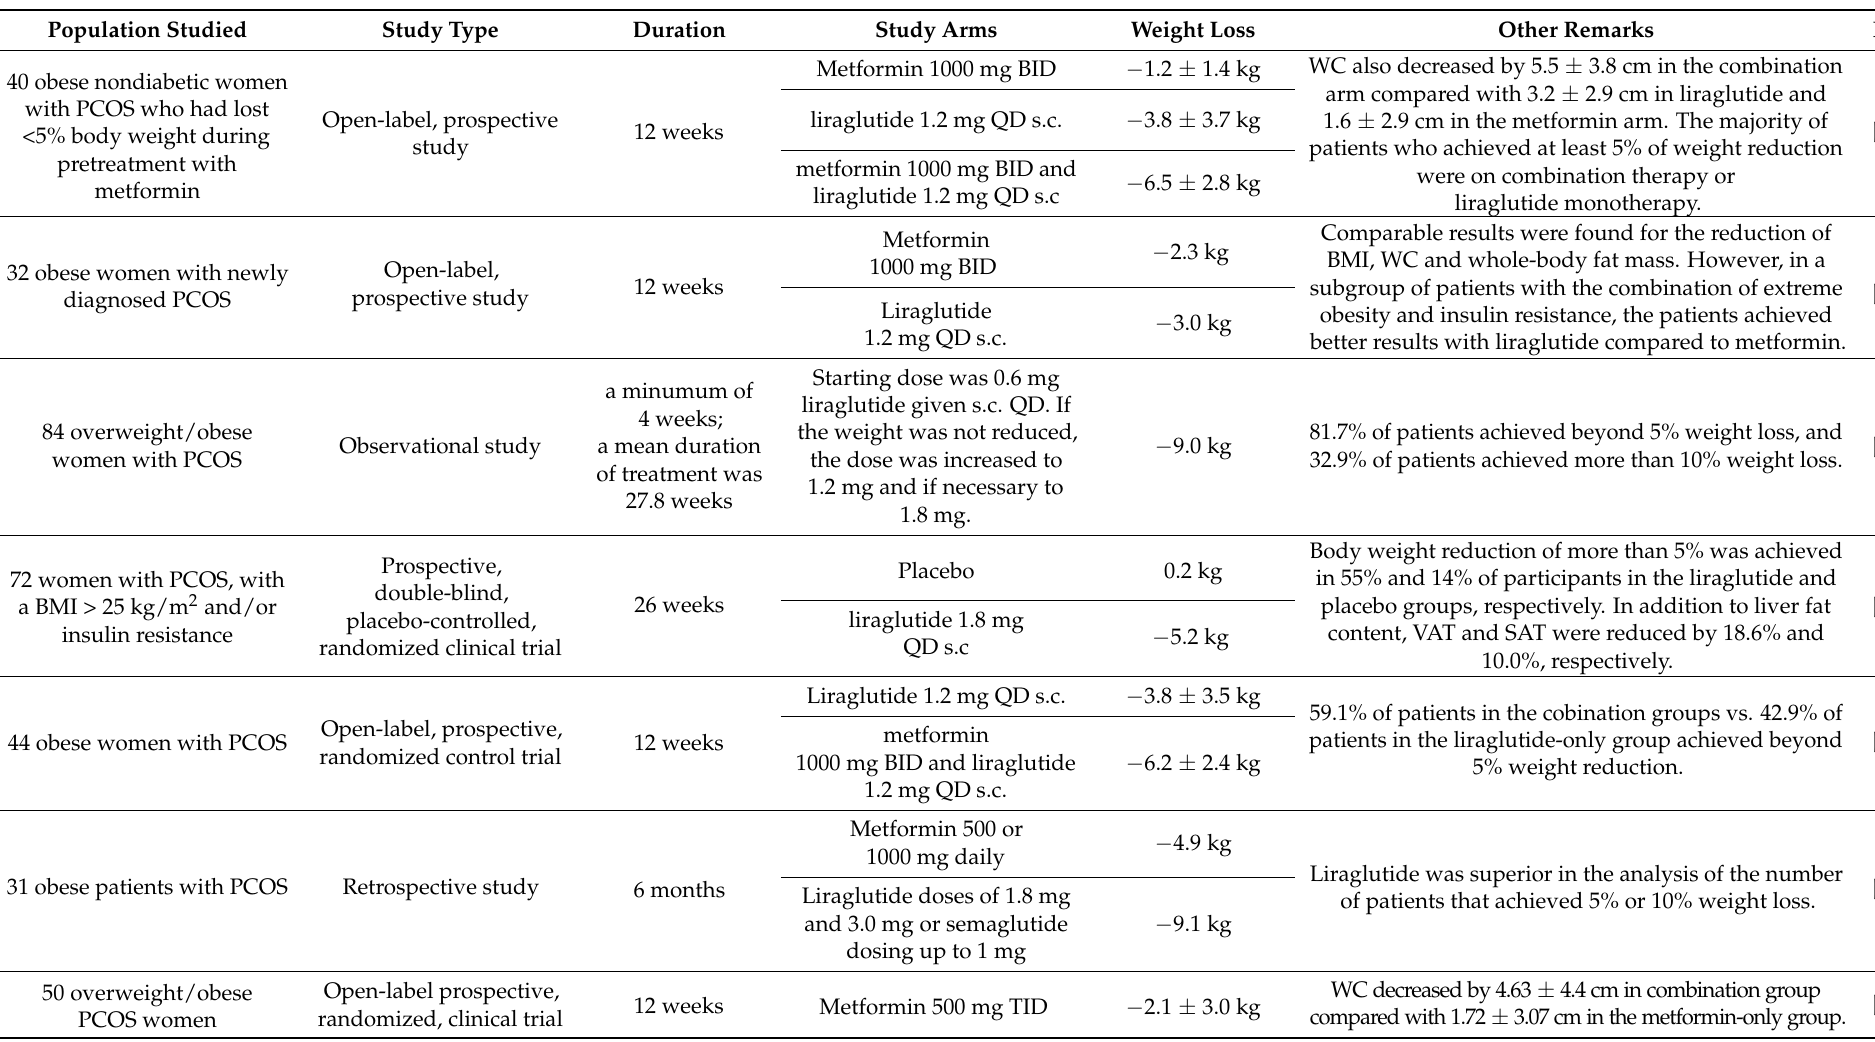
Table 1. Clinical studies that measured the weight loss effects of GLP-1RAs in